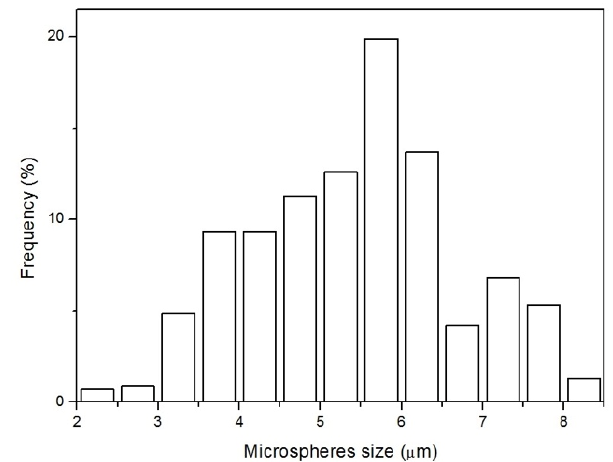
Figure 2. Size histogram of the hydrochar microspheres, giving an average value and standard deviation of 5.4 and 1.3 µ m, respectively.